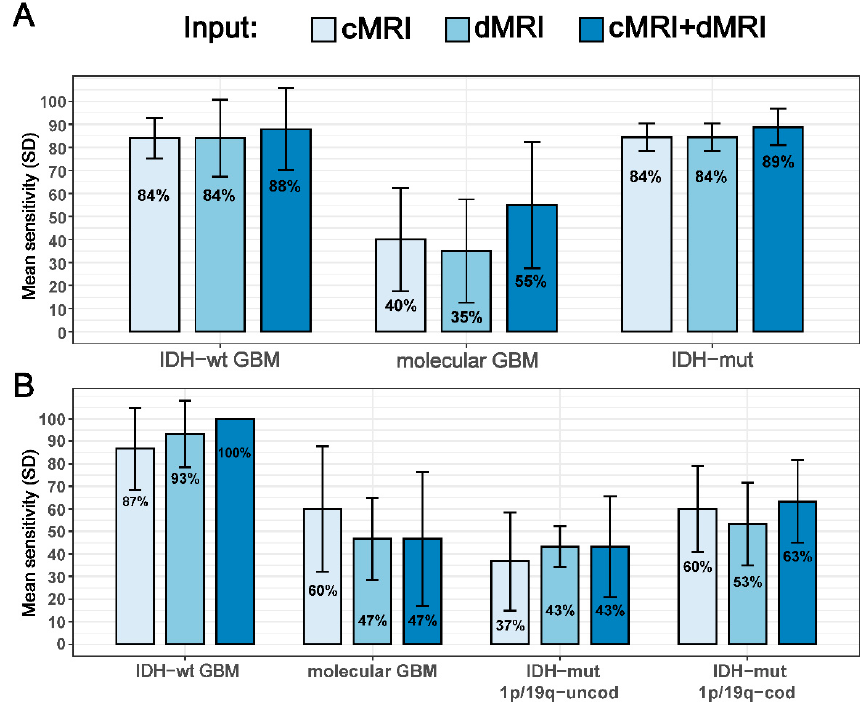
Figure 4. Individual molecular subtype prediction performance of the networks using different MR images as inputs for two tasks in the second round of analysis that included glioblastomas: ( A ) IDH status prediction and ( B ) three-group molecular subtype prediction. The numbers within the coloured bars are the average sensitivities over the five test sets in the outer loop and the vertical black bars represent the corresponding standard deviations. cMRI = conventional MRI; dMRI = diffusion MRI; IDH-wt = IDH-wildtype; GBM = glioblastoma; IDH-mut = IDH-mutant; 1p/19q-cod = 1p/19q-codeleted; 1p/19q-uncod = 1p/19q-uncodeleted.